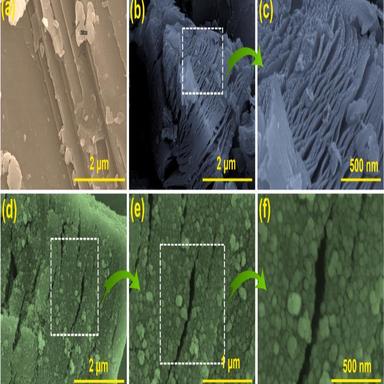
FE-SEM images of (a) V2AlC MAX phase, (b, c) V2CTx-MXene, and (d–f) low–high magnification images of NixB/V2CTx-75 composites.